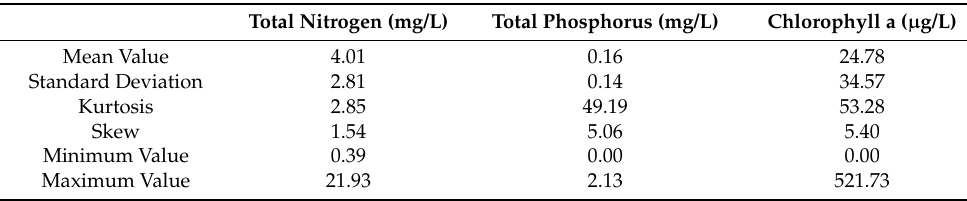
Table 1. The statistics of the observations in Taihu Lake.